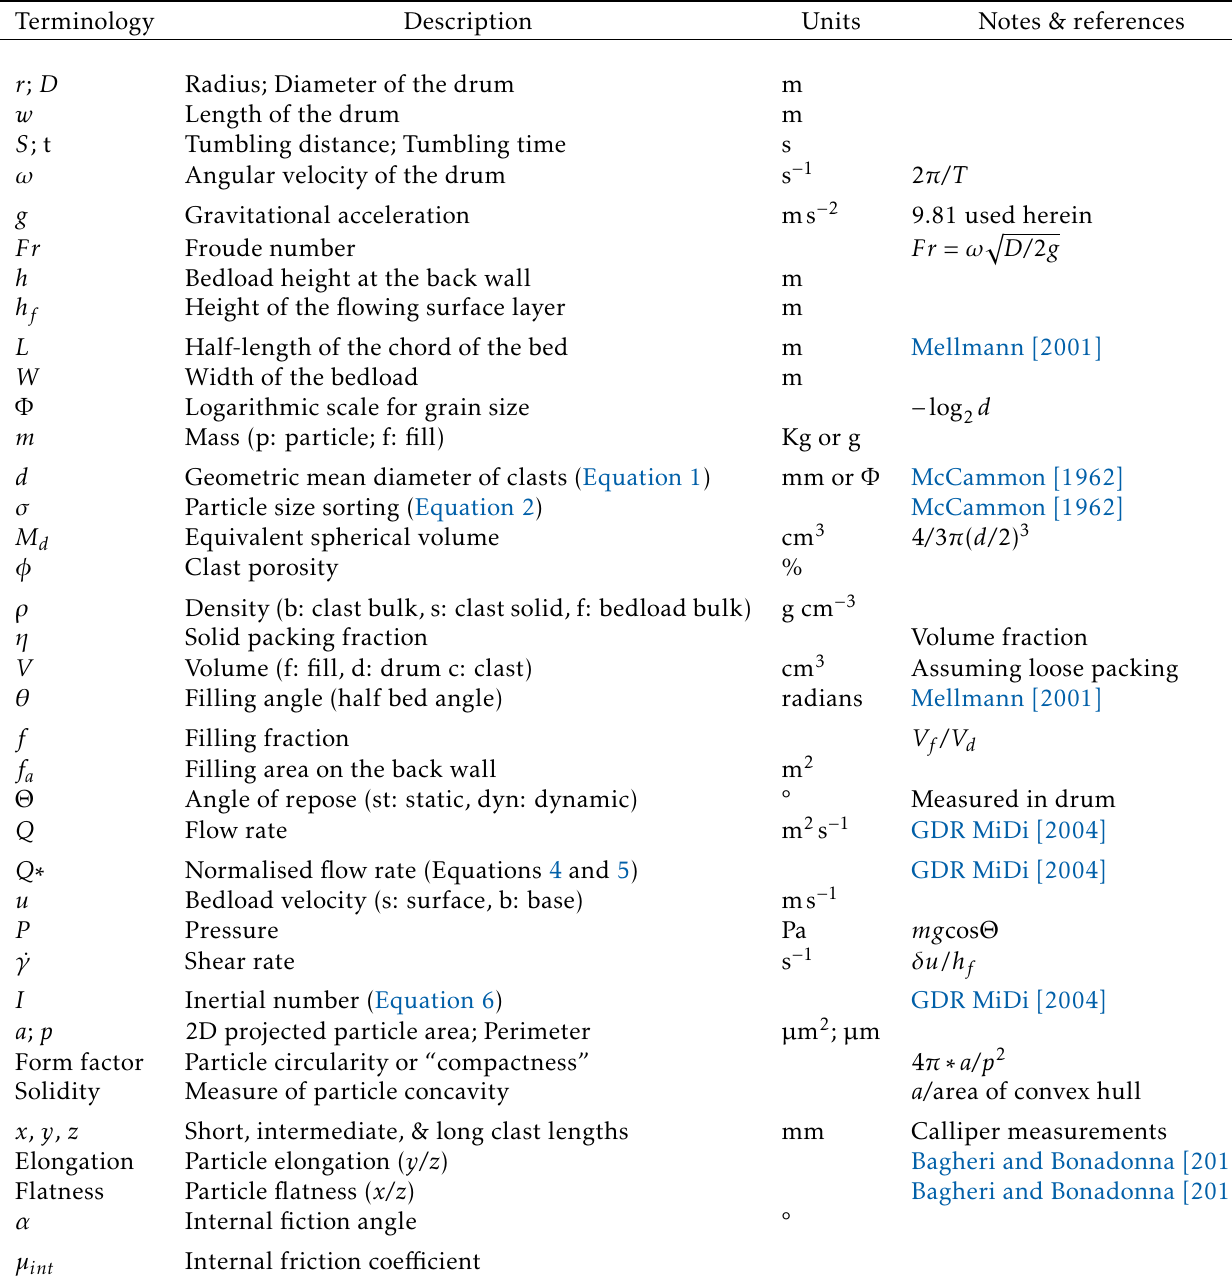
Table 1 – Notation and terms